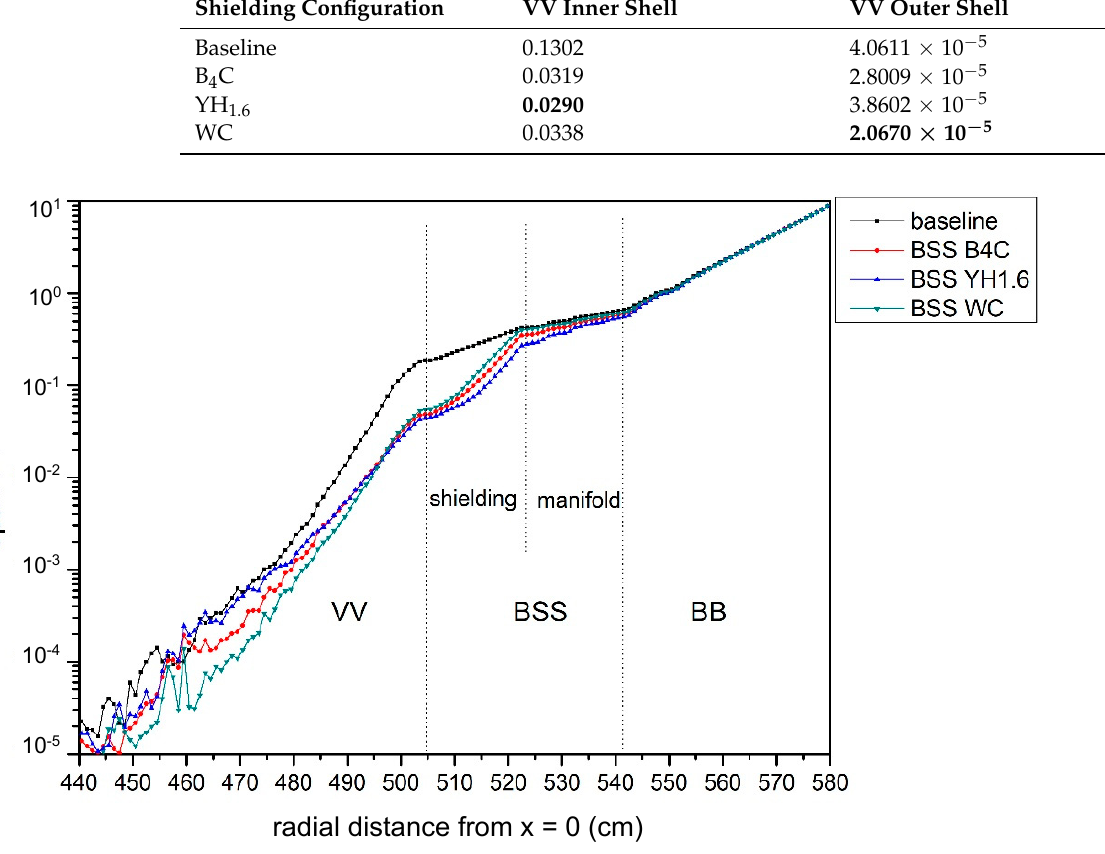
Figure 2. Radial profile at the IB equatorial plane from the FW to the VV of the dpa/FPY for the baseline model and the 3 shielding configurations.